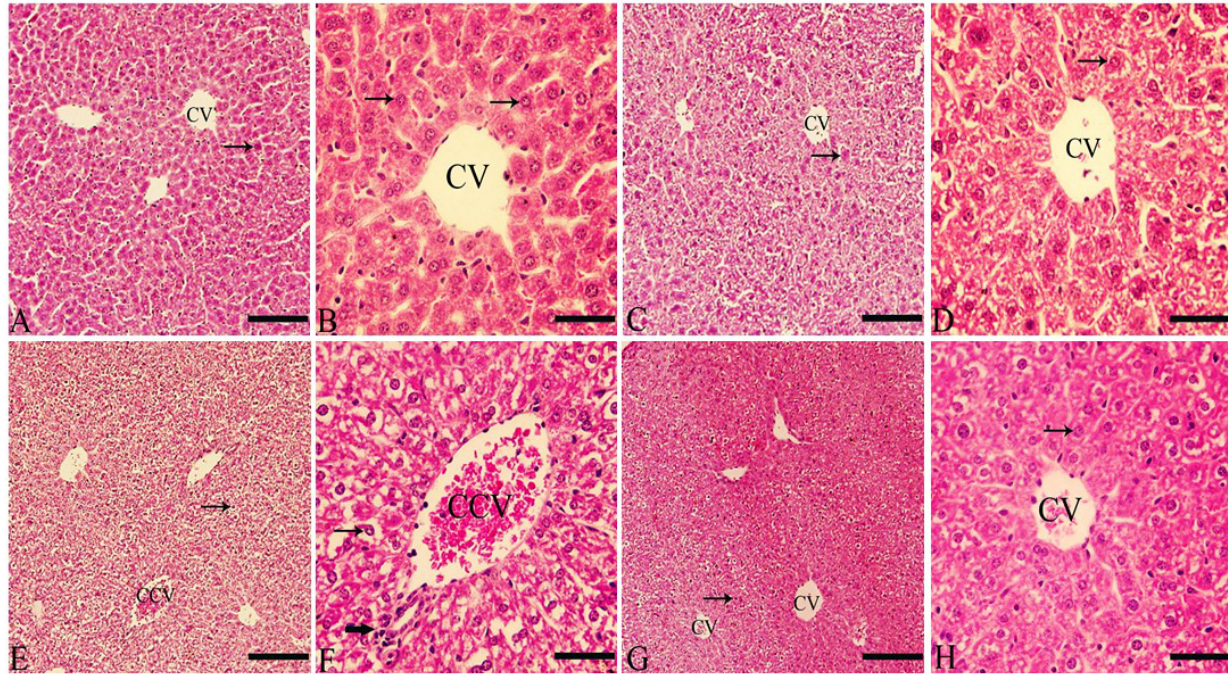
Figure 3. Photomicrographs of hematoxylin and eosin (H&E)-stained sections in the liver of ( A , B ) Control and ( C , D ) A. graveolens -treated mice showing normal hepatic cells (thin arrow), central vein (CV), inflammatory cells (thick arrow), ( E , F ) nicotine-exposed newborns showing congested central vein observed (CCV), degeneration of some hepatic cells and ( G , H ) nicotine-exposed newborns treated with A. graveolens showing ameliorated liver structure. [Scale bar = 50 μm ( A , C , E , G ) and 200 μm ( B , D , F , H )].